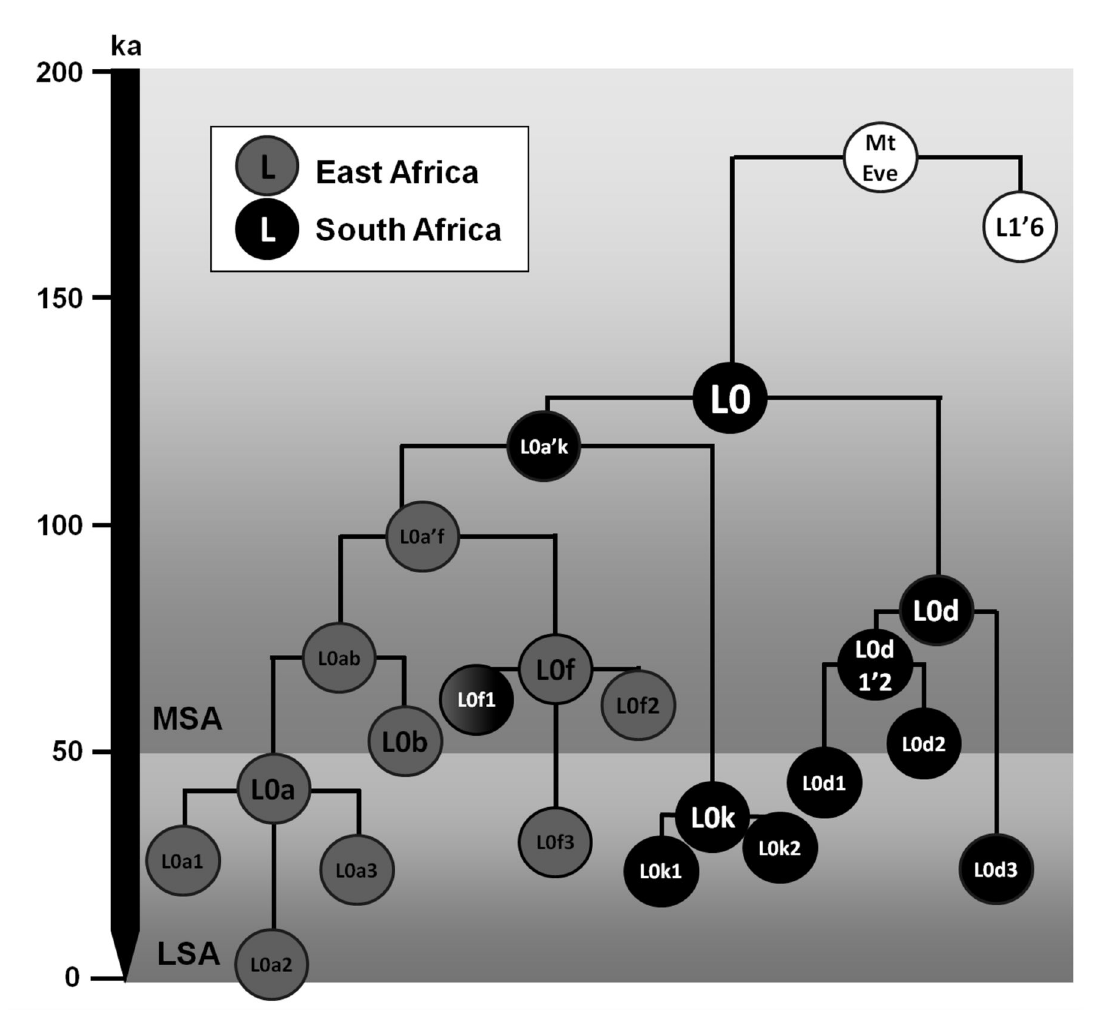
Figure 1. Schematic tree of haplogroup L0 and the root of the human mtDNA diversity. The tree is scaled against the maximum likelihood (ML) age estimates (in ka). Colour scheme for each clade indicates the probable geographic origin (eastern or southern